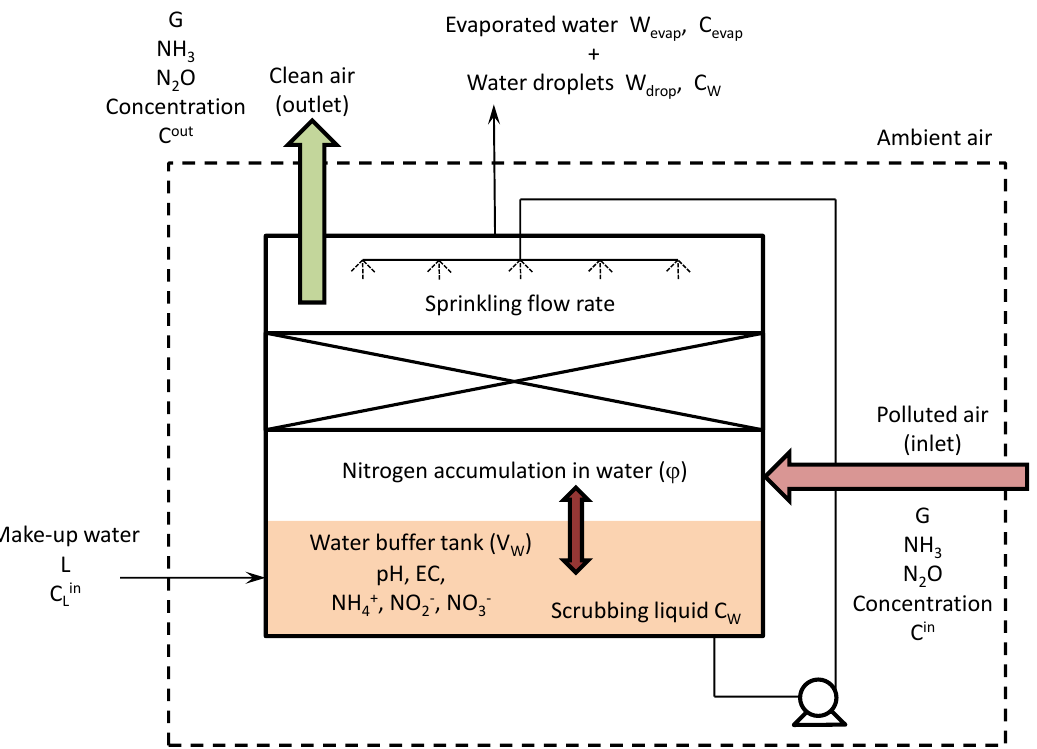
Figure 1. Schematic representation of the biotrickling filter ( G : gas flow rate, m 3 h −1 ; L: fresh liquid flow rate (make-up water), m 3 h −1 ; W evap : evaporated water flow rate, m 3 h −1 ; W drop : droplet entrainment flow rate, m 3 h −1 ; C evap : nitrogen concentration in evaporated water (=0 gN L −1 ); C W : nitrogen concentration in water, gN L −1 ; V W : water volume in the tank, m 3 ). ChemEngineering 2020 , 4 , x FOR PEER REVIEW Table 1. Henry’s law solubility constants at 298.15 K [14] .